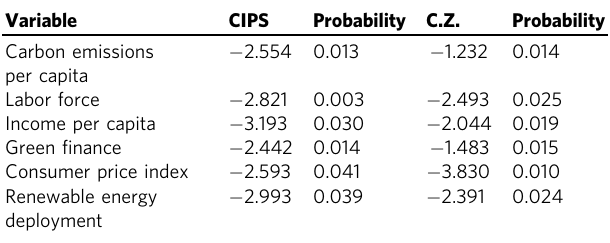
Table 3 Second-generation panel unit root tests.